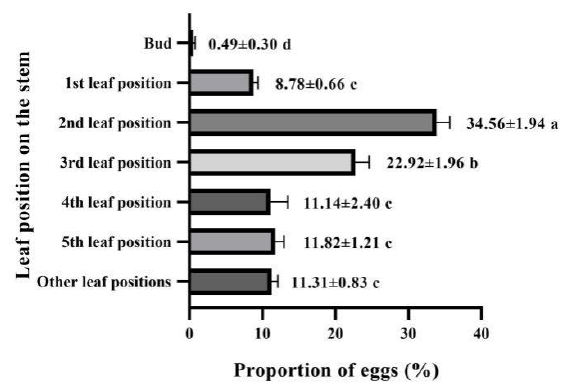
Figure 3. Configuration of the leaf positions on a tender tea shoot. The first leaf position was between the first and second leaf nodes, the second leaf position was between the second and third leaf nodes, the third leaf position was between the third and fourth leaf nodes, and by parity of reasoning for the other leaf positions.